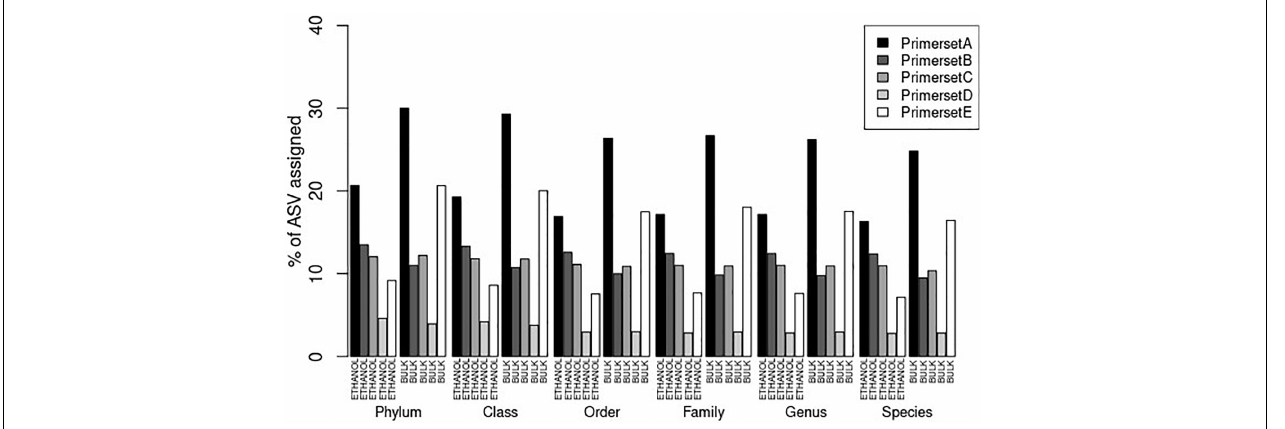
FIGURE 2 | Percentage of ASVs found in ethanol (ETHANOL) and bulk (BULK) samples that received taxonomic assignment at the different taxonomic levels for each primer set. Unrarified datasets were used to capture the most complete taxonomic assignments for each primer set. For each dataset, the number of assigned ASVs were normalized to the total number of ASVs for that particular